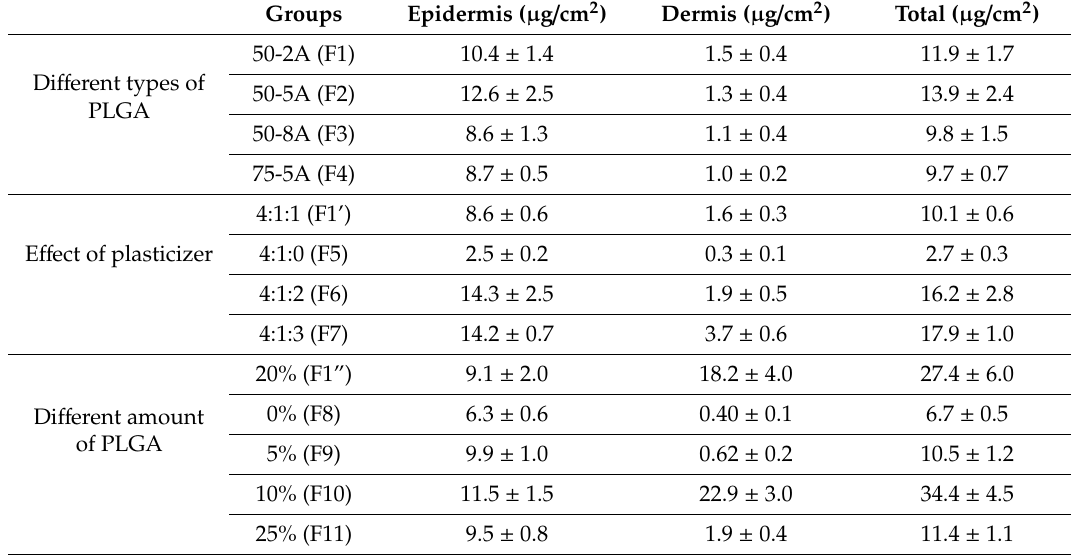
Figure 4. Permeation profiles of TS through porcine ear skin for the different types of PLGA. The group is representative of different types of PLGA: ( a ) Cumulative amount ( b ) Average amount in the epidermis, dermis, and total skin.